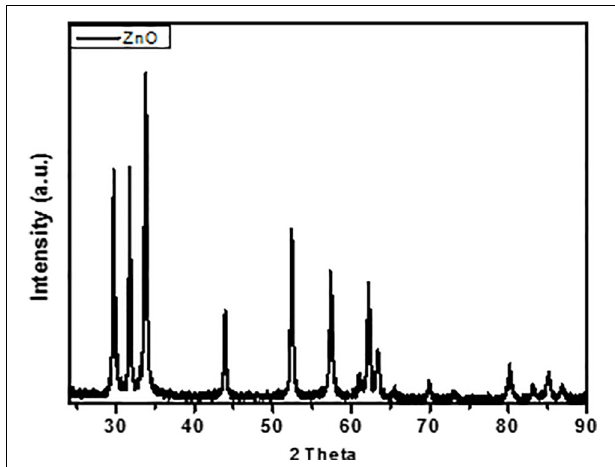
FIGURE 4 | XRD patterns of as-prepared ZnO nano boxes.